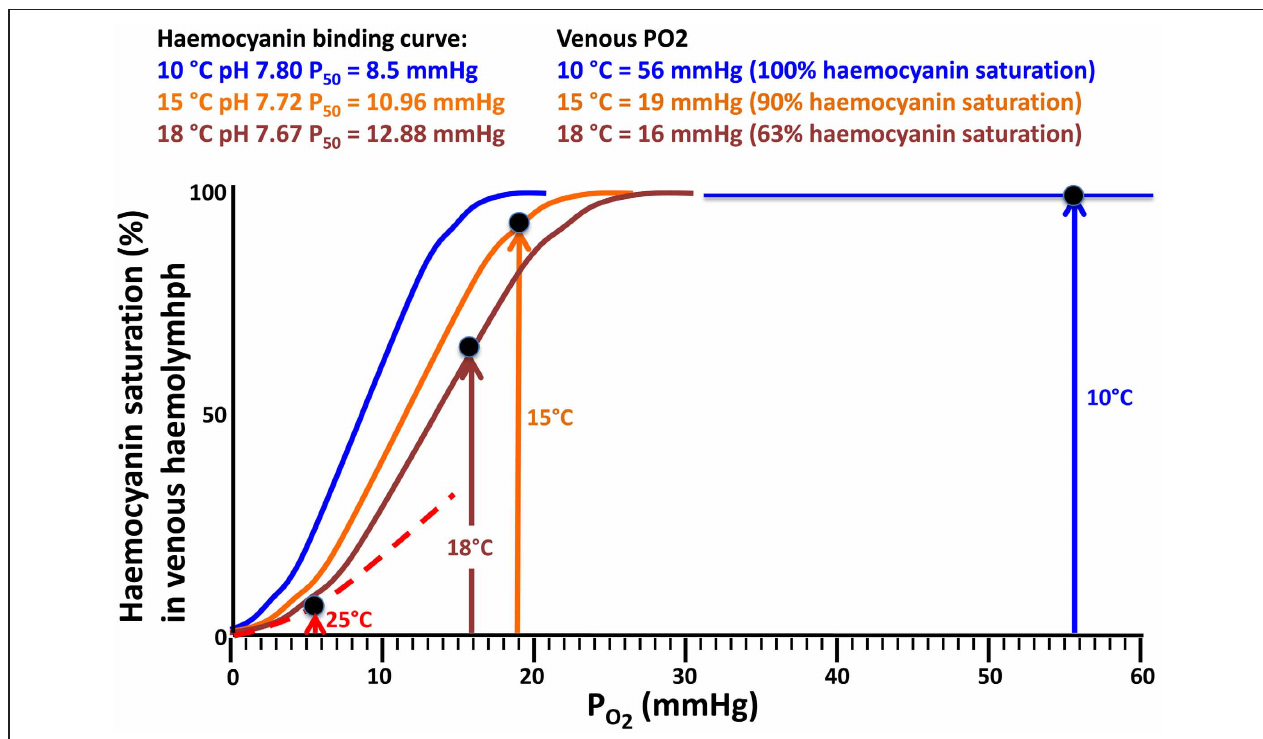
FIGURE 6 | Temperature dependent oxygen binding curves and haemocyanin oxygen saturation levels (data from Weber et al., 2008) resulting from venous P O 2 data (Figure 5), thereby illustrating how venous oxygen saturation develops with warming. For further explanations see Materials and